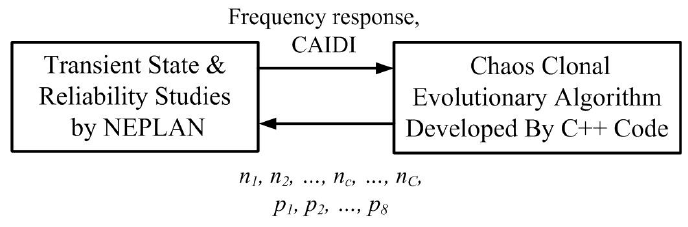
Figure 2. Co-simulation conducted in the proposed method.